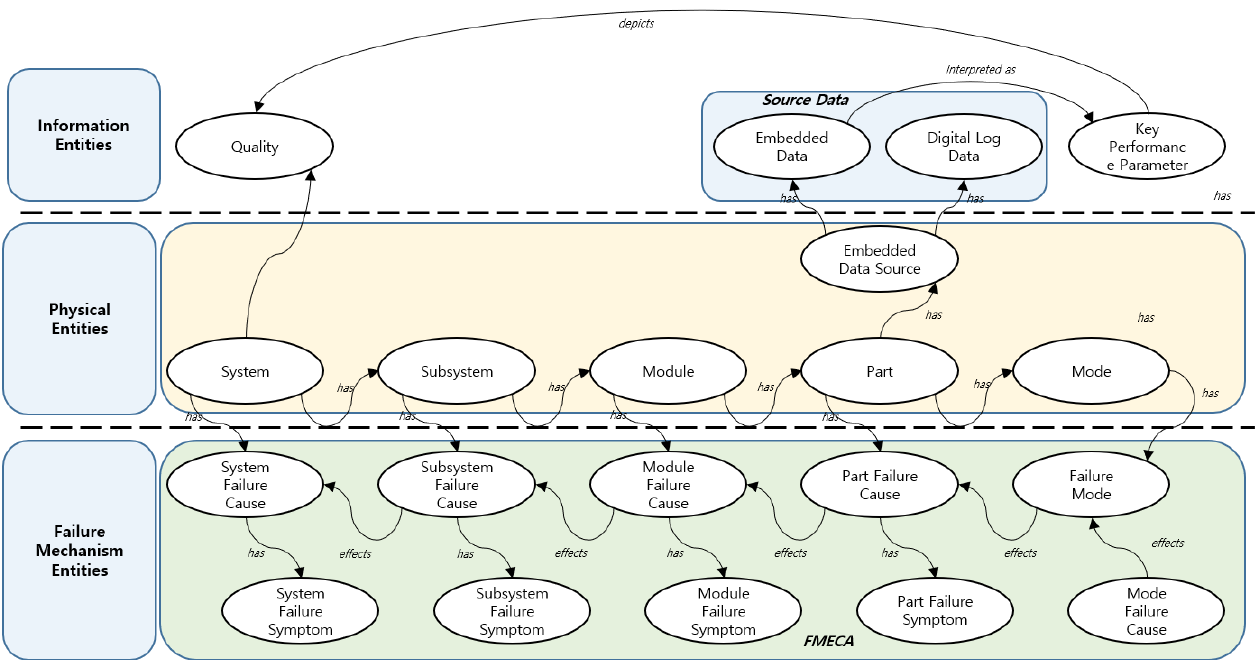
Figure 3. Logical diagram of maintainable items and failure mechanisms.